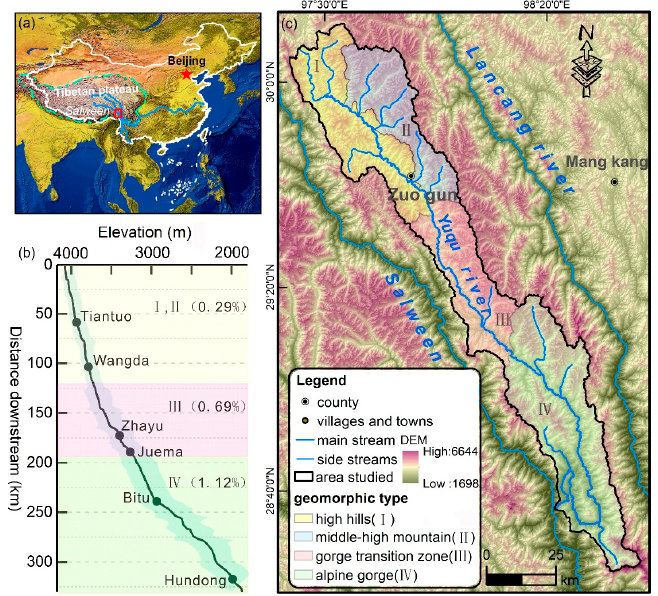
Figure 1. ( a ) Location of Yuqu River Basin in Tibetan Plateau. ( b ) The Yuqu River profile line. ( c ) Shade relief of DEM and the I, II, III and IV geomorphic zones. ( c ) Shade relief of DEM and the I, II, III and IV geomorphic